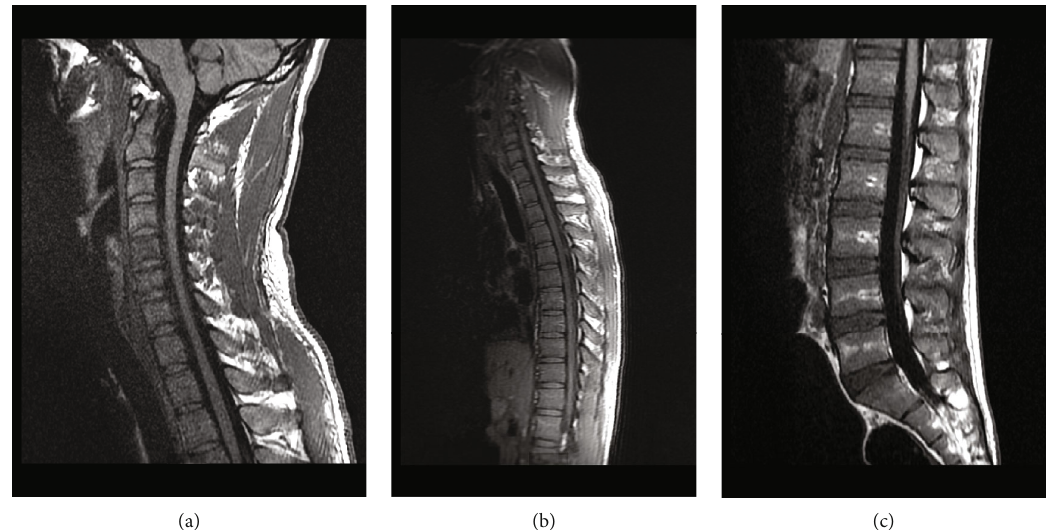
Figure 2: MRI of the cervical (a), thoracic (b), and lumbar spine (c) showing no evidence of leptomeningeal spread.